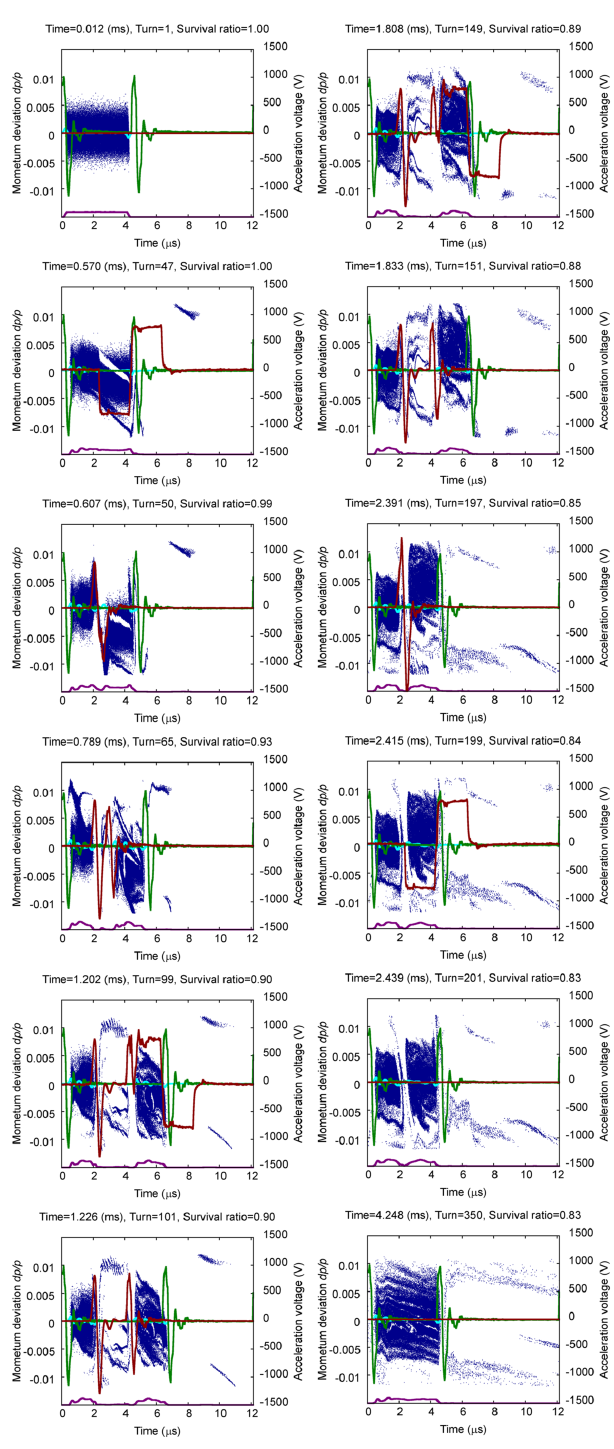
FIG. 10. Snapshots of the beam distribution in the longitudinal phase space in the offDBB at the 1st, 47th, 50th, 65th, 99th, 101st, 149th, 151st, 197th, 199th, 201st, and 350th turns, from the top left to the bottom right. The red-colored line indicates the superimposed waveform of the two intermediate voltages and an auxiliary voltage. Other colored lines are the same as those in Fig.